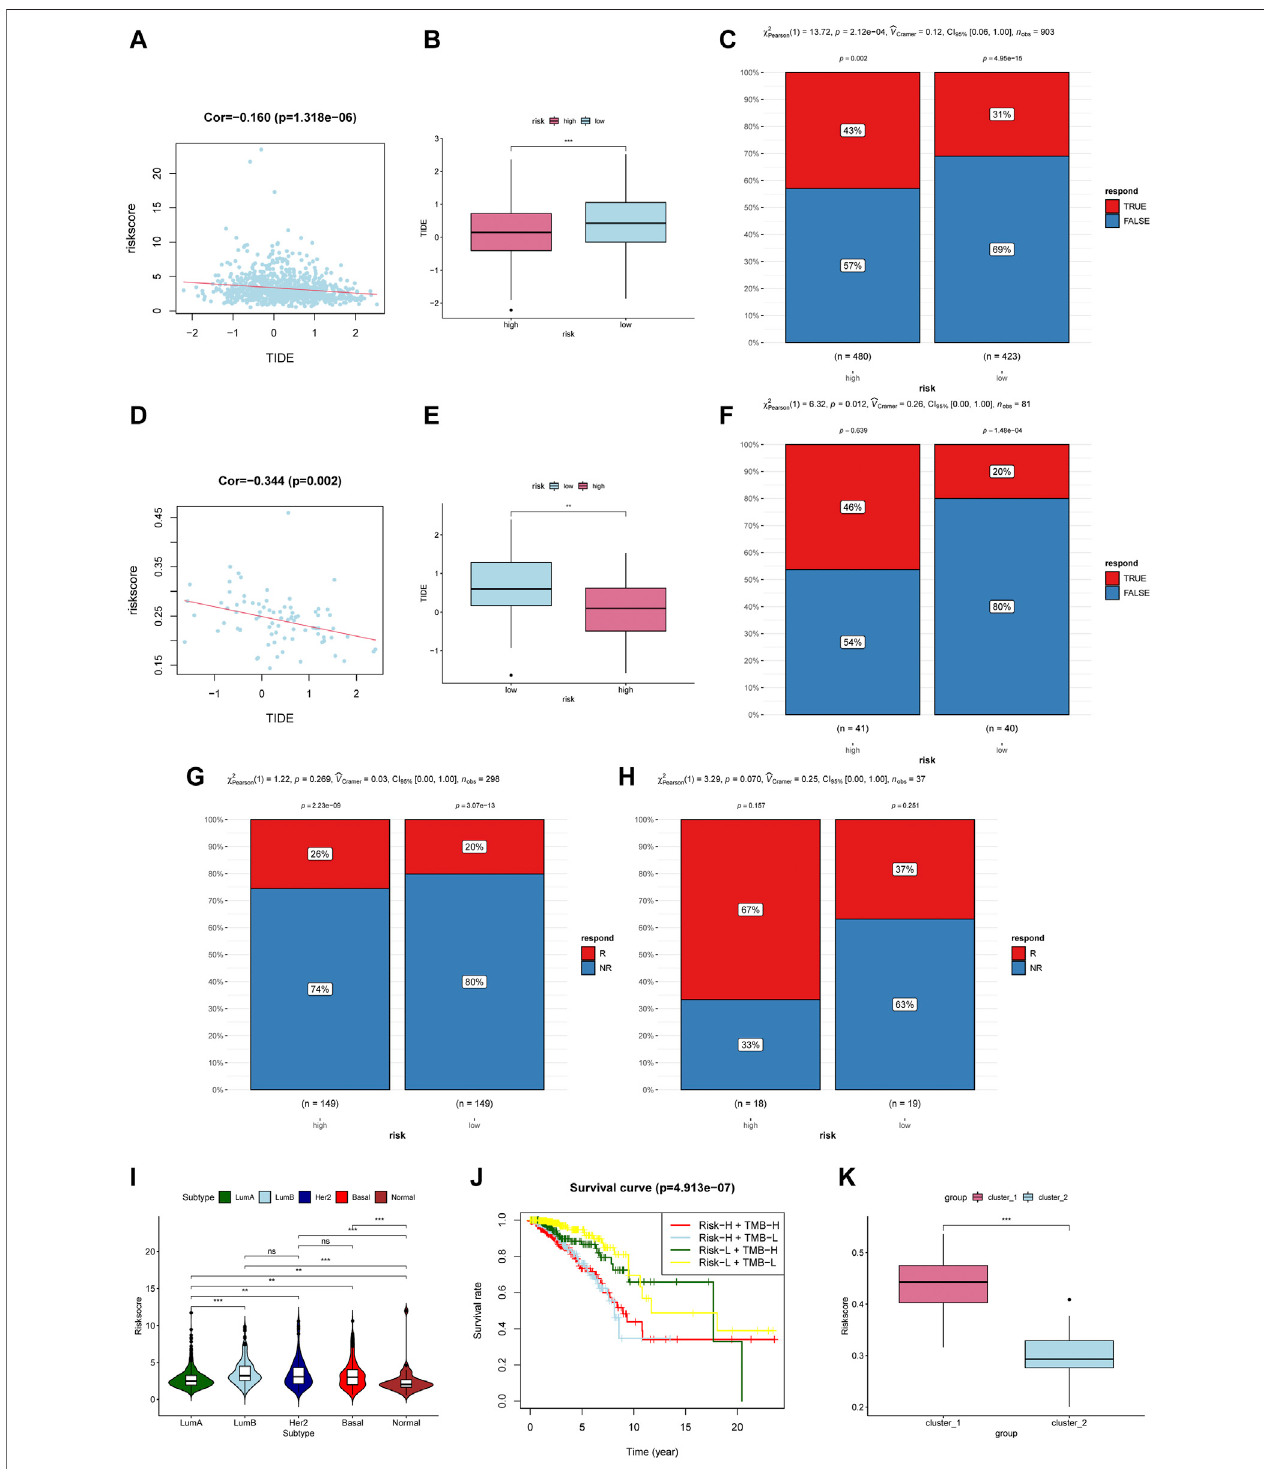
FIGURE9| M6ariskscorepredictstheresponseofimmunotherapy. (A) CorrelationanalysisbetweenTIDEvalueandm6aRiskscoreintheTCGA-BRCAcohort. (B) BoxplotofTIDEvalue betweensubgroupsintheTCGA-BRCAcohort. (C) Rate ofclinicalresponseestimated byTIDEinhigh orlowm6aRiskscoregroupsintheTCGA- BRCAcohort. (D) Correlation analysisbetweenTIDEvalueand m6aRiskscoreintheGSE48391 cohort. (E) BoxplotofTIDEvaluebetweensubgroupsintheGSE48391 cohort. (F) Rateofclinicalresponseestimated byTIDEinhigh orlowm6aRiskscoregroups intheGSE48391 cohort. (G) Rateofclinicalresponse (response [R]/no response[NR])toanti-PD-L1immunotherapyinhighorlowm6aRiskscoregroupsintheIMvigor210cohort. (H) Rateofclinicalresponse(R/NR)toimmunosuppressives (methotrexate and cyclophosphamide) in high or low m6aRiskscore groups in the GSE42664 cohort. (I) m6aRiskscore in different molecular subtype of breast cancer. (J) Survival analyses for patients strati fi ed by both TMB and m6aRiskscore. (K) Boxplot of m6aRiskscore between Cluster1 and Cluster2.